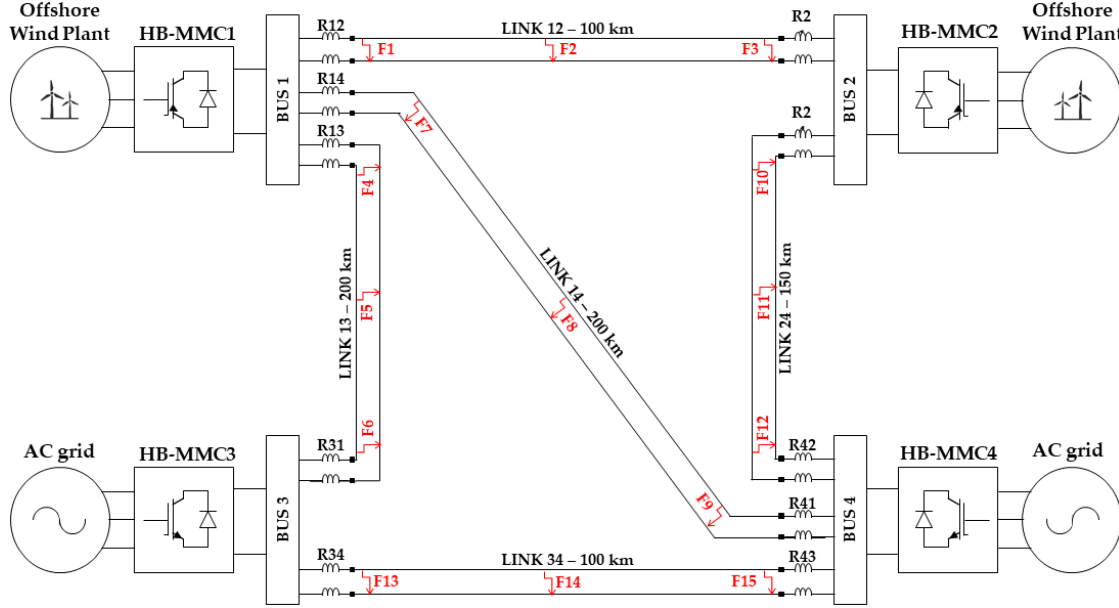
Figure 8. Diagram of the four-terminal HVDC system with locations of the simulated faults.